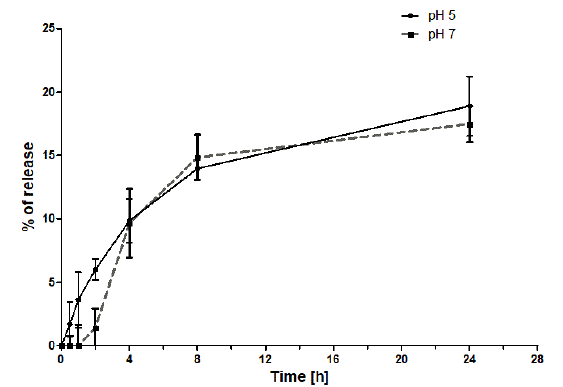
Figure 7. Release of RB from the G3–3RB–pyrro conjugate under different pH conditions. Data presented as mean ± SD.